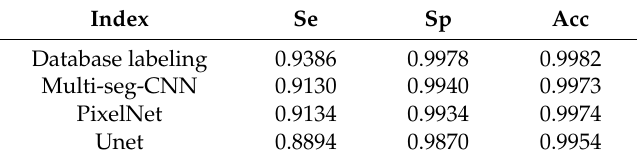
Table 2. The results of the different networks of cup optic disc and macula.